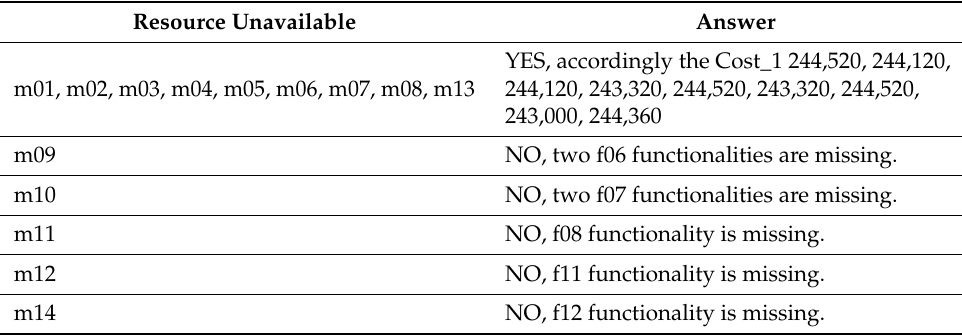
Table 6. Answers for all variants of question Q_3 .